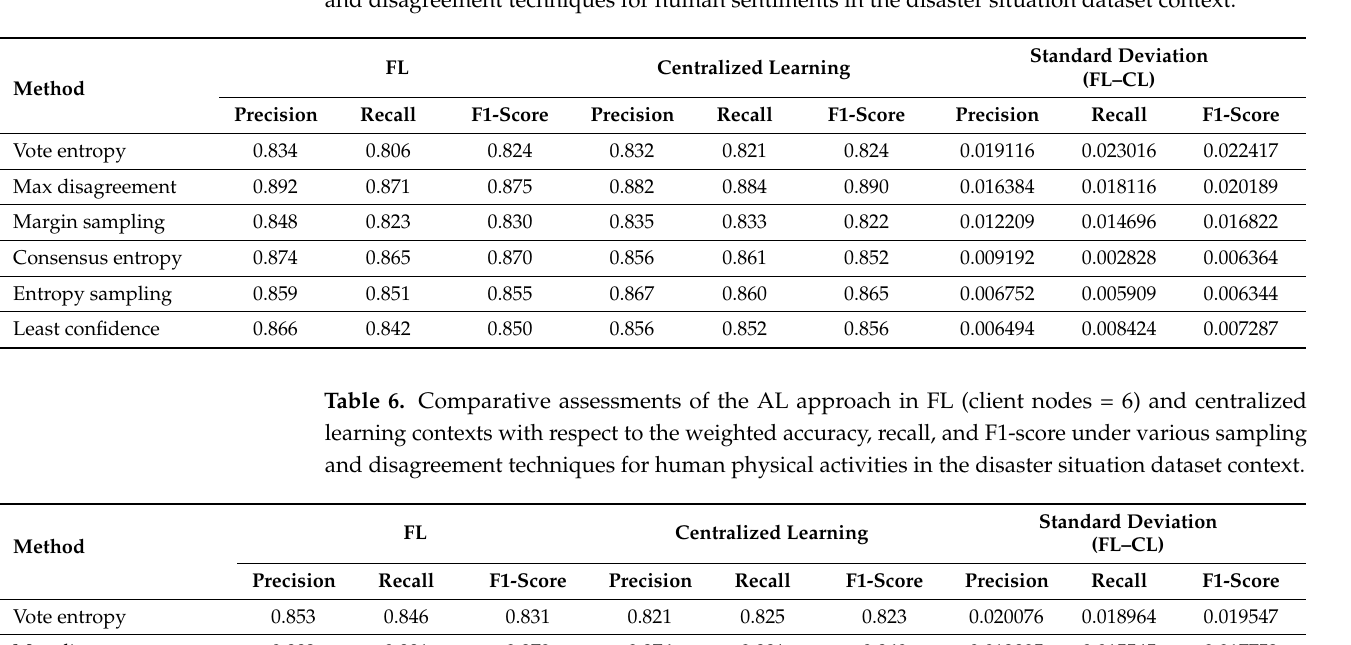
Table 5. Comparative assessments of the AL approach in FL (client nodes = 6) and centralized learning contexts with respect to the weighted accuracy, recall, and F1-score under various sampling and disagreement techniques for human sentiments in the disaster situation dataset context.